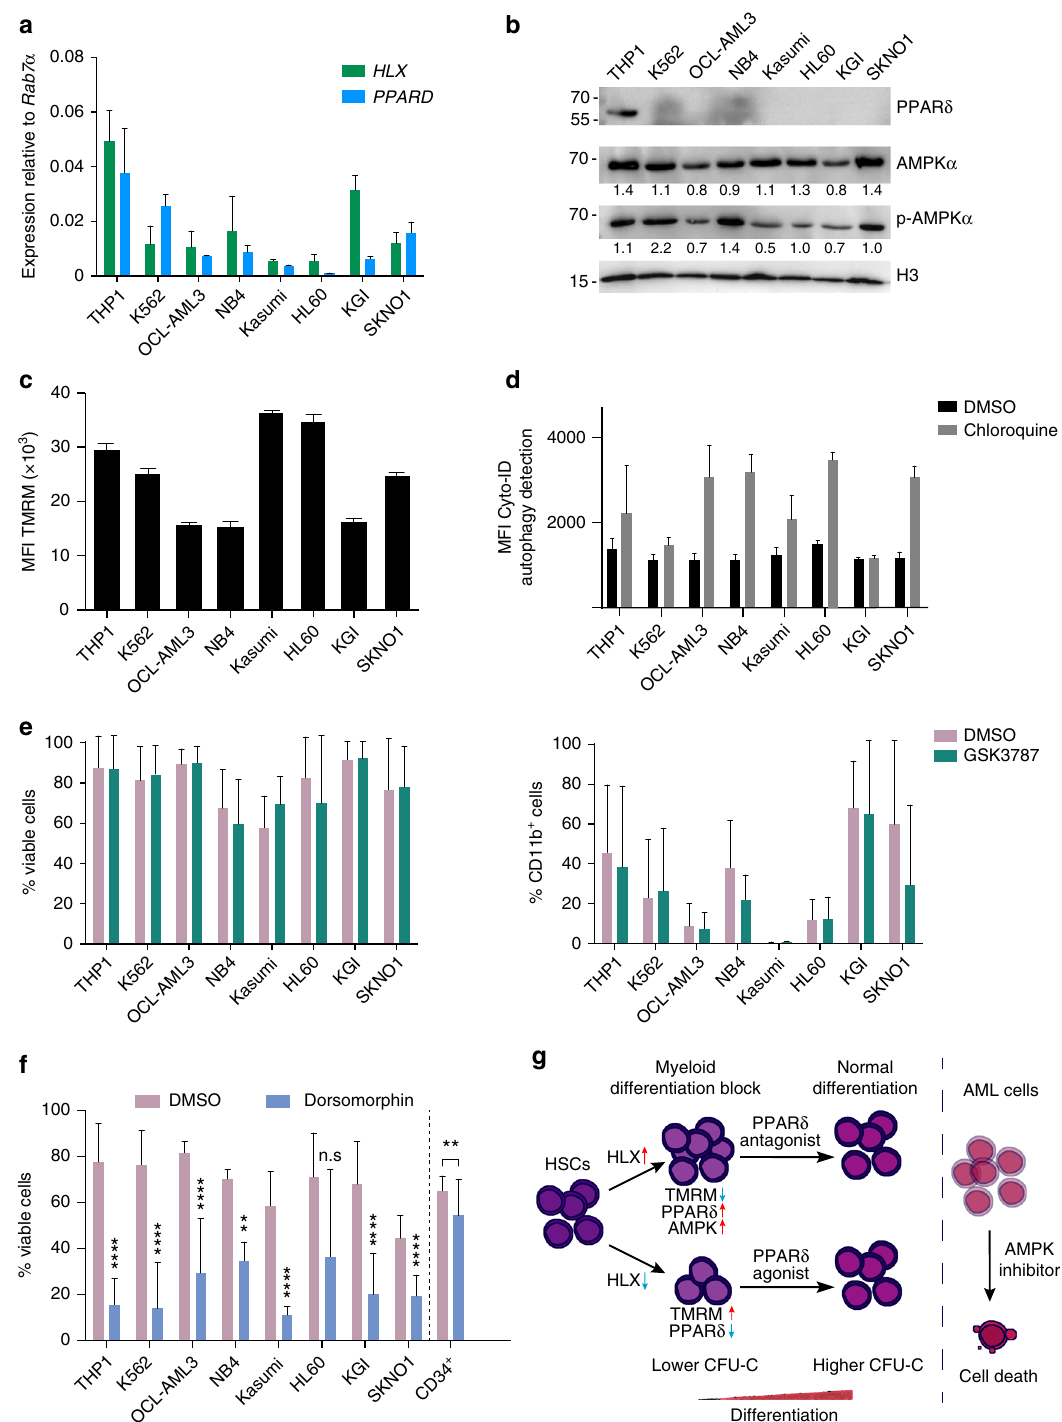
Fig. 8 AMPK inhibition causes lethality in AML cell lines. a qPCR expression analysis of HLX and PPAR δ in AML cell lines and K562 cells ( n = 2, mean + s.e.m.). b Representative western blot analysis for PPAR δ ( n = 4), AMPK α ( n = 3), p-AMPK α ( n = 2) and H3 as loading control in different AML cell lines and K562 cells. Quanti fi cations shown below the panels, as a ratio to H3, were performed by FIJI software. c Mitochondrial membrane potential measured by TMRM in AML cell lines and K562 cells. MFI median fl uorescence intensity (representative of two independent experiments, mean + s.d.). d Flow cytometry analysis of autophagic fl ux in different AML cell lines and K562 cells incubated with DMSO or chloroquine. MFI median fl uorescence intensity (representative of two independent experiments, mean + s.d.). e Measurement of viable cells (left panel) or CD11b staining as a marker of myeloid differentiation (right panel) with or without the PPAR δ antagonist GSK3787 ( n = 5, mean + s.d.). f Measurement of viable cells after incubation of different AML cell lines and K562 cells or WT CD34 + cells with or without dorsomorphin ( n = 3, mean + s.d., Student ’ s t -test, ** P < 0.01, **** P < 0.0001). g Model of HLX function in